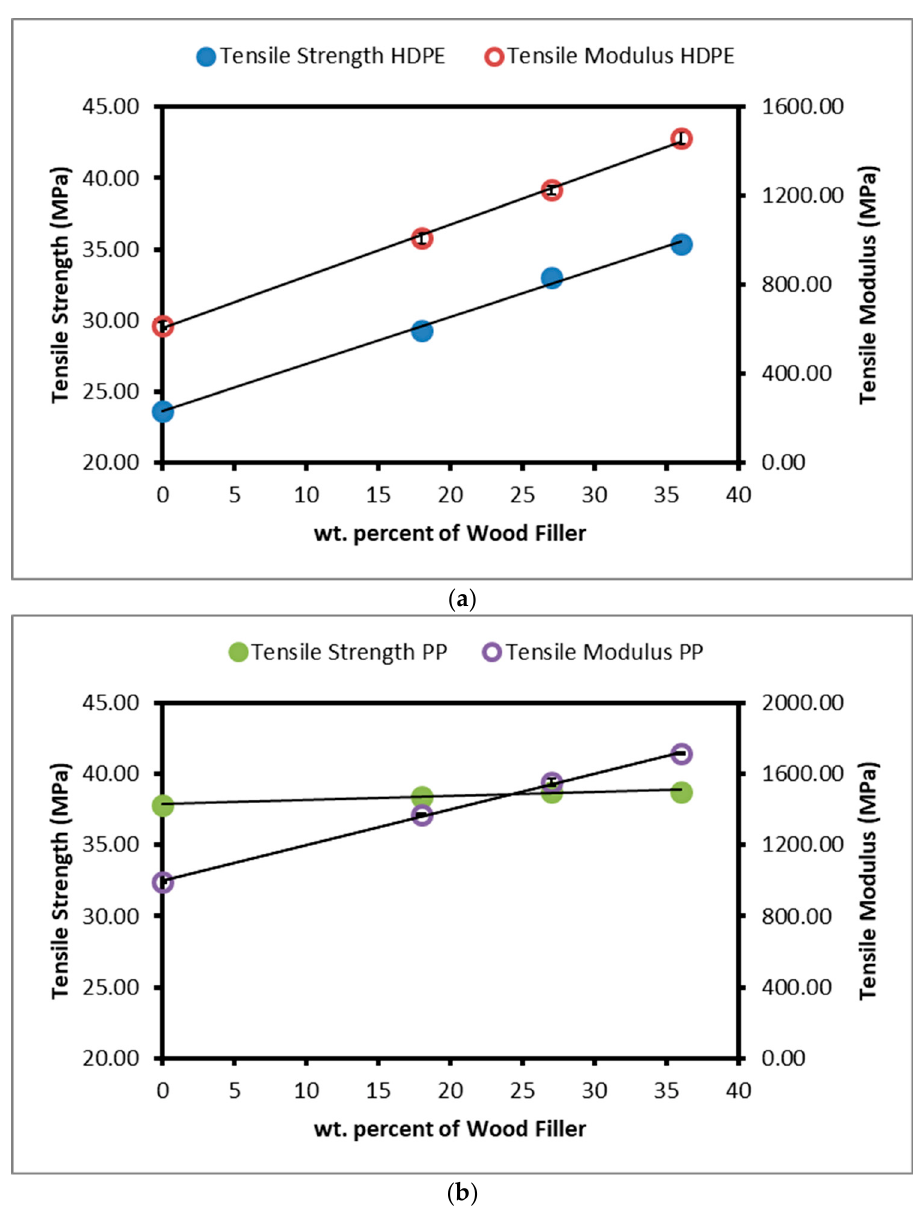
Figure 4. A comparison of the change in the tensile modulus and tensile strength with different percentage weight of filler for ( a ) HDPE wood composite and ( b ) PP wood composite Table 2. Summary of tensile test data for the control samples and three formulations of HDPE and PP.